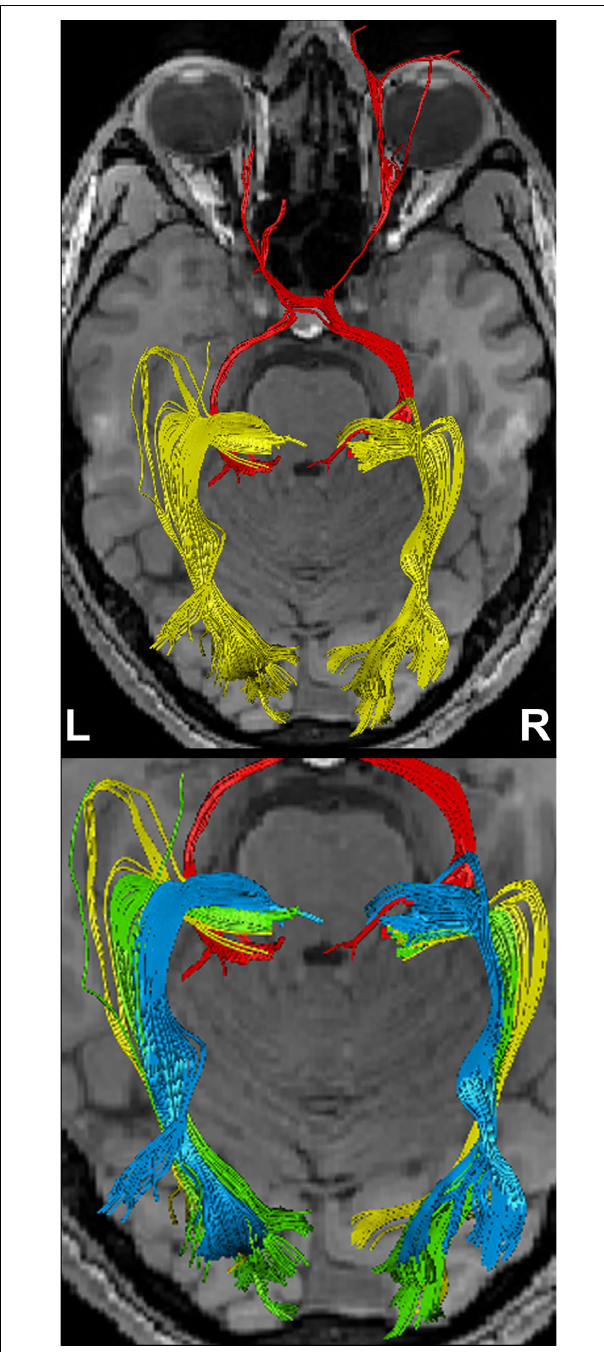
FIGURE 4 | (Top) Bi-hemispheric reconstructions of the optic nerve and tract (red) as well as of the optic radiation (yellow). (Bottom) Dissection of the optic radiation into Meyer’s loop (yellow), central bundle (green), and dorsal bundle (blue). R, right, L, left.